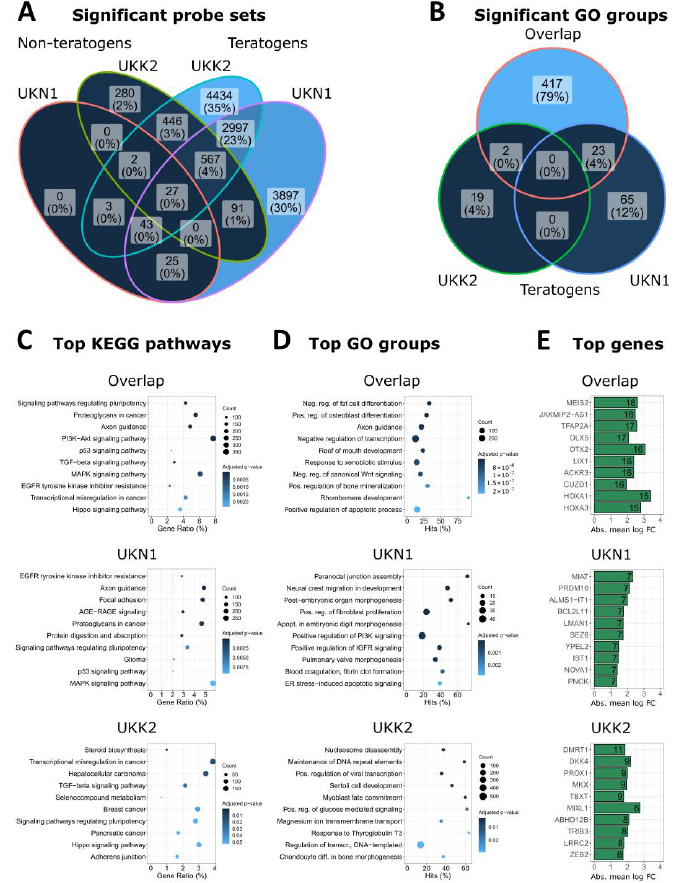
Figure 6. Biological interpretation and comparison of genes differentially expressed in the UKN1 and UKK2 test after exposure of hiPSC to teratogens at 20-fold C max . ( A ) Number of significant probe sets (log2 fold change >1; adjusted p -value < 0.05) induced by non-teratogens and teratogens at the 20-fold C max (including also 10-fold C max carbamazepine and 1.67-fold C max VPA). The following gene sets were defined: ‘Overlap:’ SPS that were deregulated by teratogens in UKN1 and UKK2 (3634 SPS); ‘UKN1 (cid:48) and ‘UKK2:’ SPS that were deregulated by teratogens exclusively in UKN1 (4013 SPS) and UKK2 (4885 SPS), respectively. ( B ) Number of significantly (adj. p -value < 0.05) overrepresented GO groups in the gene sets ‘Overlap,’ ‘UKN1,’ and ‘UKK2.’ ( C ) KEGG pathway enrichment analysis of the gene sets ‘Overlap,’ ‘UKN1,’ and ‘UKK2.’ The ten KEGG pathways with the lowest adj. p -values are given. Full names and complete KEGG-pathway lists are given in the Supplementary Excel-file 4. “Count:” number of significant genes from A linked to the KEGG pathway. “Gene Ratio:” percentage of significant genes associated with the pathway compared to the number of all significant genes associated with any pathway. ( D ) The ten GO groups with the lowest adj. p -values from all significantly (adj. p -value <0.05) overrepresented GO groups in each gene set. The following adjustments applied here: ‘Overlap’ included all GO groups encompassed by the overlap-circle in B (442 GO groups); ‘UKN1 (cid:48) (65 GO groups) and ‘UKK2 (cid:48) (19 GO groups) only considered remained GO groups. The names of the GO groups were shortened. Full names and complete GO group lists can be found in the Supplementary Excel-file 5. “Count:” Number of significant genes from A linked to the GO group. “Hits:” percentage of significant genes compared to all genes assigned to the GO group. ( E ) Top-10 genes deregulated by teratogens within each gene set. The number in the bar indicates the number of compounds that deregulated the specific gene. The absolute mean log fold-change of each gene is given on the x -axis. A comprehensive gene list is provided in the Supplementary Excel-file